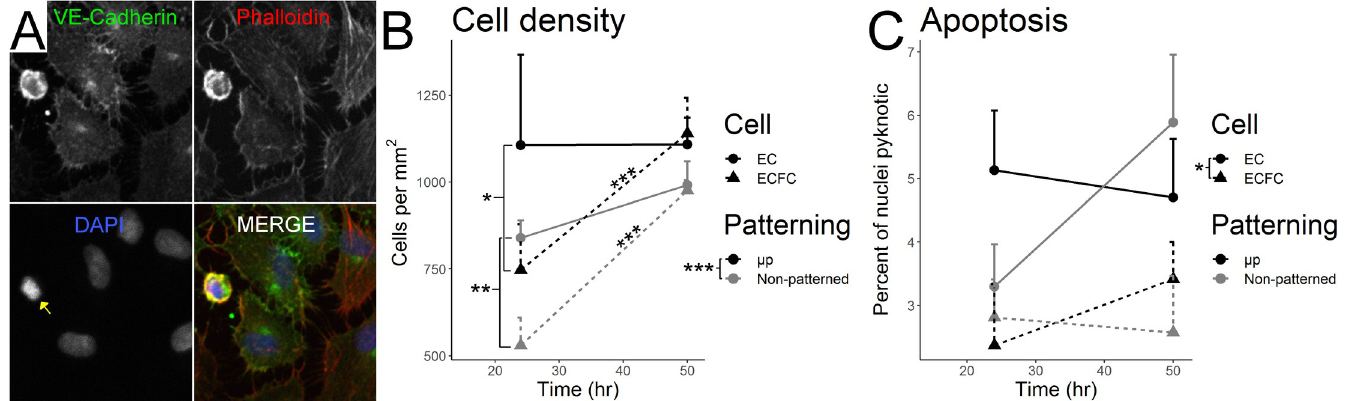
Fig 3. Micropatterning significantly increases cell density. EC apoptotic rate is higher than ECFC, regardless of micropatterning. Stained EC and ECFC nuclei were counted in order to quantify cell density and apoptotic rate. (A) Representative micrograph of a pyknotic nucleus (yellow arrow, DAPI channel) surrounded by healthy cells in a non-patterned EC sample after 50 hours of culture. (B) Micropatterning significantly increases cell density across other culture conditions (p = 0.0002). Post-hoc testing showed significantly greater EC than ECFC density at 24 hours in both non-patterned (p = 0.0024) and micropatterned cells (p = 0.011), however no significant cell-type differences existed after 50 hours (p = 1, both). As noted by stars above trend lines, ECFC density significantly increased between 24 and 50 hours of culture time in both non-patterned (p = 0.0009) and micropatterned (p = 0.0002) cultures, while EC density did not (p = 1 non-patterned, p = 0.689 μ p). (C) ECs showed a significantly greater rate of apoptosis than ECFCs across culture conditions (p = 0.0151), however micropatterning (p = 0.732) and culture time (p = 0.336) had no significant effects on apoptotic